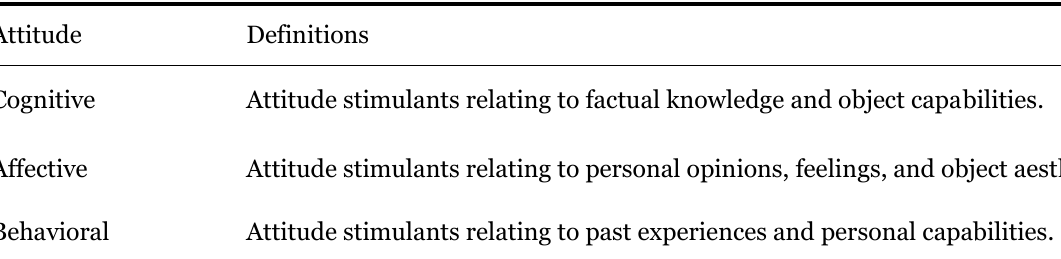
Psychological Construct of External Variables